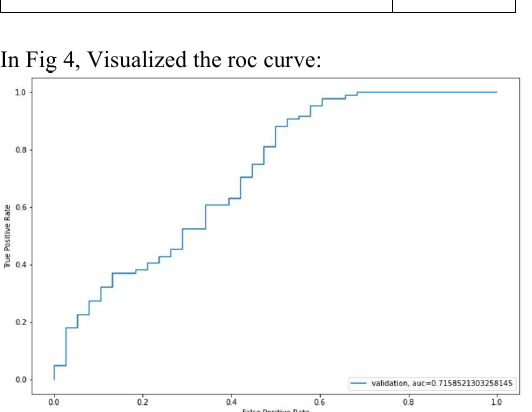
Table 2. Mean Validation Accuracy of Hyperparameters Mean Validation Accuracy